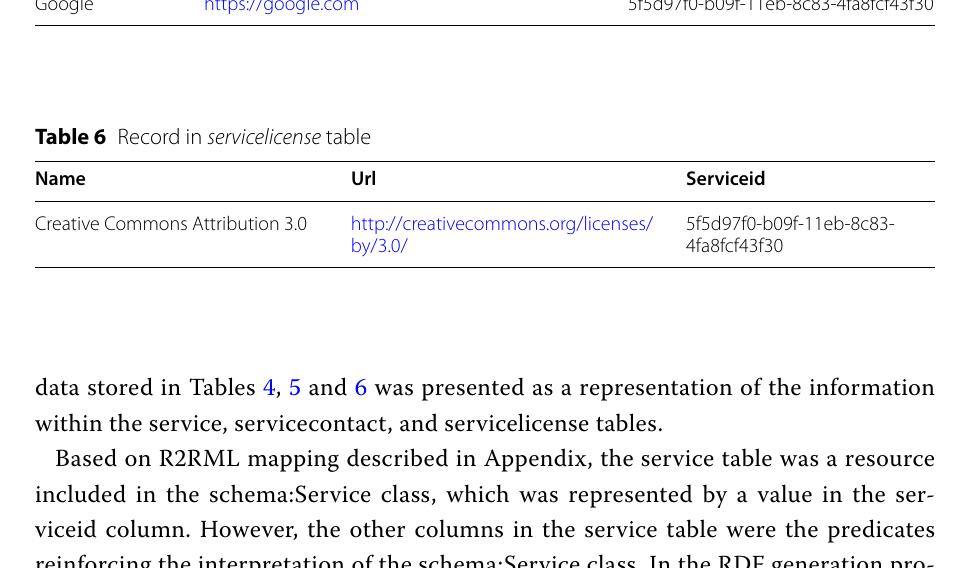
Table 5 Record in servicecontact table Name Url Email